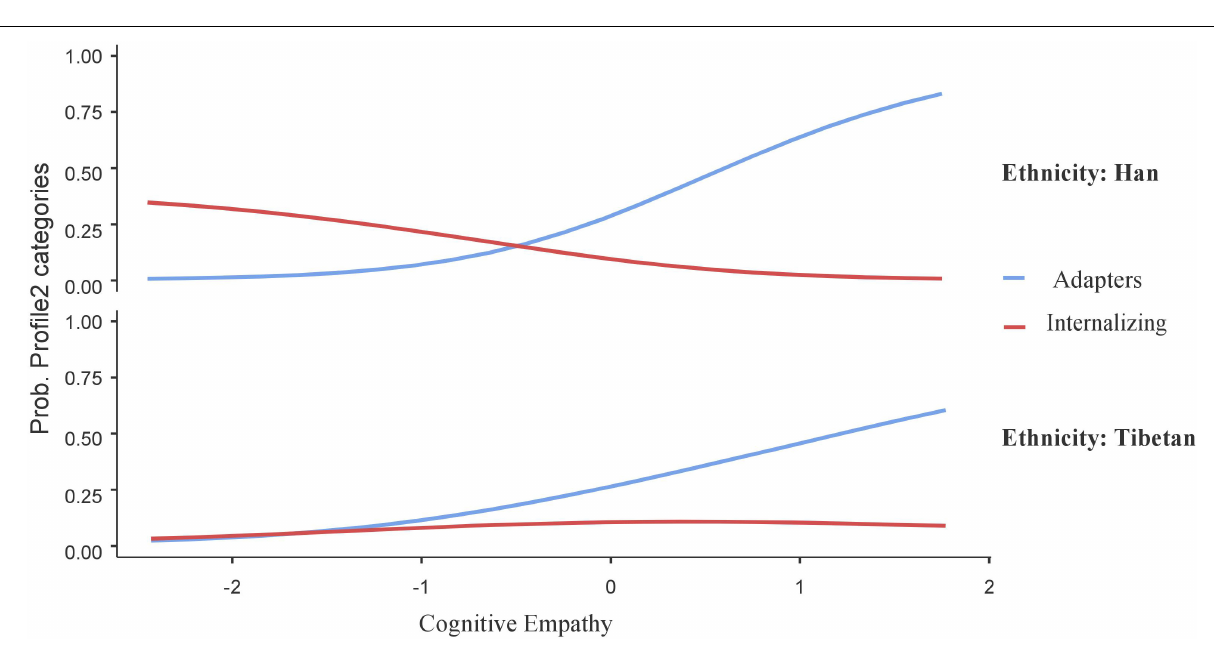
FIGURE 3 | Interaction effect of affective empathy and ethnicity on probability of adaptive and moderate profiles. N = 627.